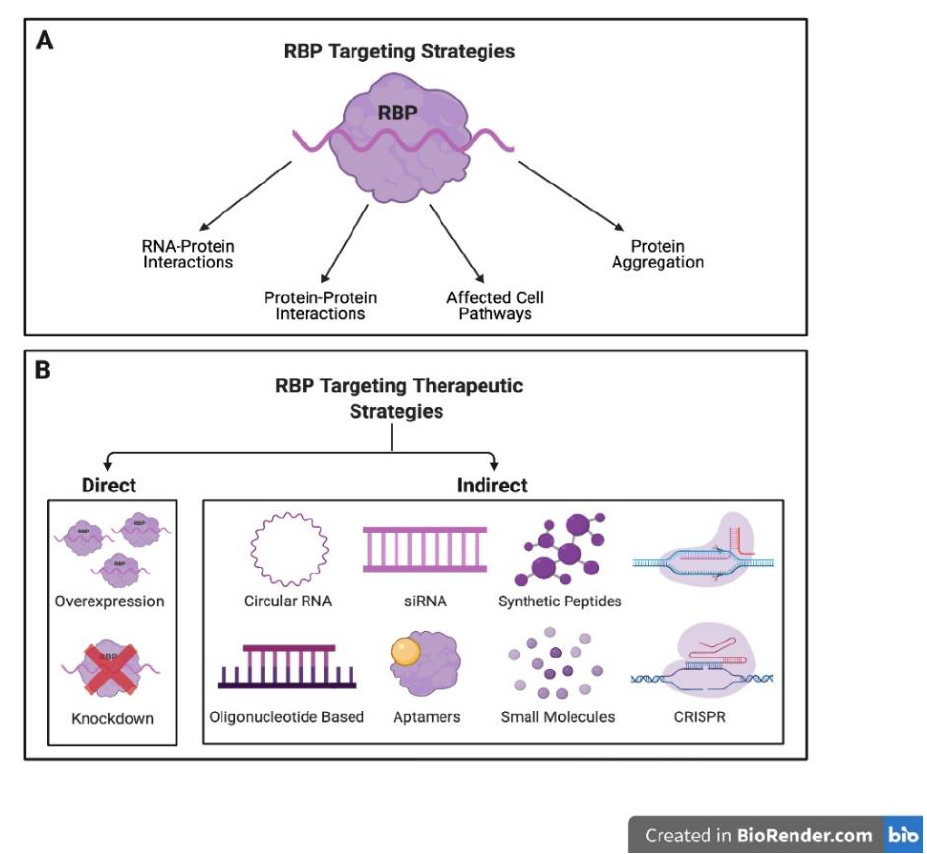
Figure 2. (A) Schematic diagram displaying RBP targeting strategies that may involve RNA-protein or protein-protein interactions, protein aggregation and cell pathways. (B) Current RBP-based targeting therapeutic strategies focus on either the manipulation of a specific RBP or an RBP-RNA interaction and so can be categorised as either direct or indirect approaches, respectively. Direct therapeutic strategies revolve around the knockdown or overexpression of a particular RBP. Indirect approaches, on the other hand, including the use of circular RNA, siRNA, synthetic peptides, oligonucleotide based, aptamers, small molecules, and CRISPR, can be designed to either inhibit the interaction of an RBP with RNA by inducing degradation, to suppress enzymatic activity, to block post transcriptional modifications or through binding to outcompete a chosen RBP. Figure created using Biorender.com.